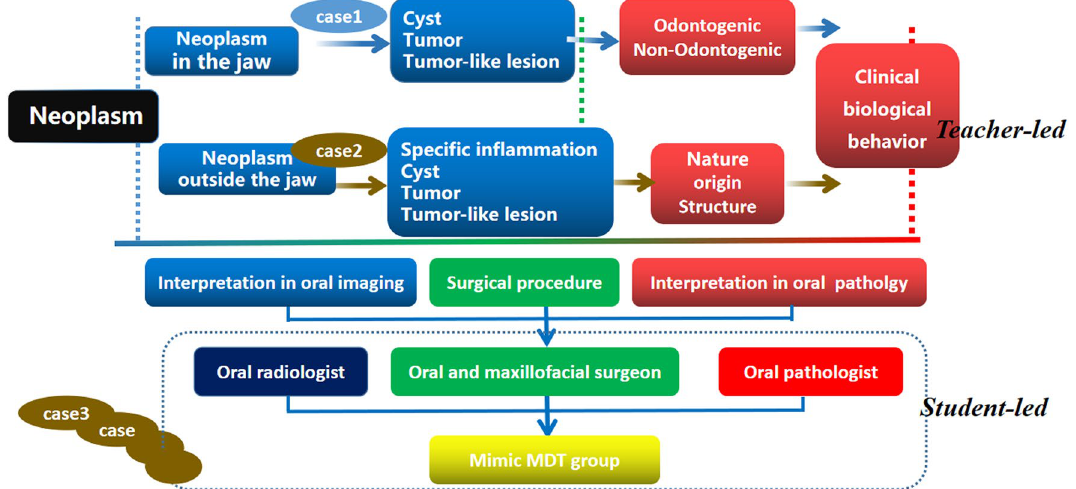
Figure 3. Cultivation mode of clinical thinking ability of Mimic MDT guided by case teaching combined with